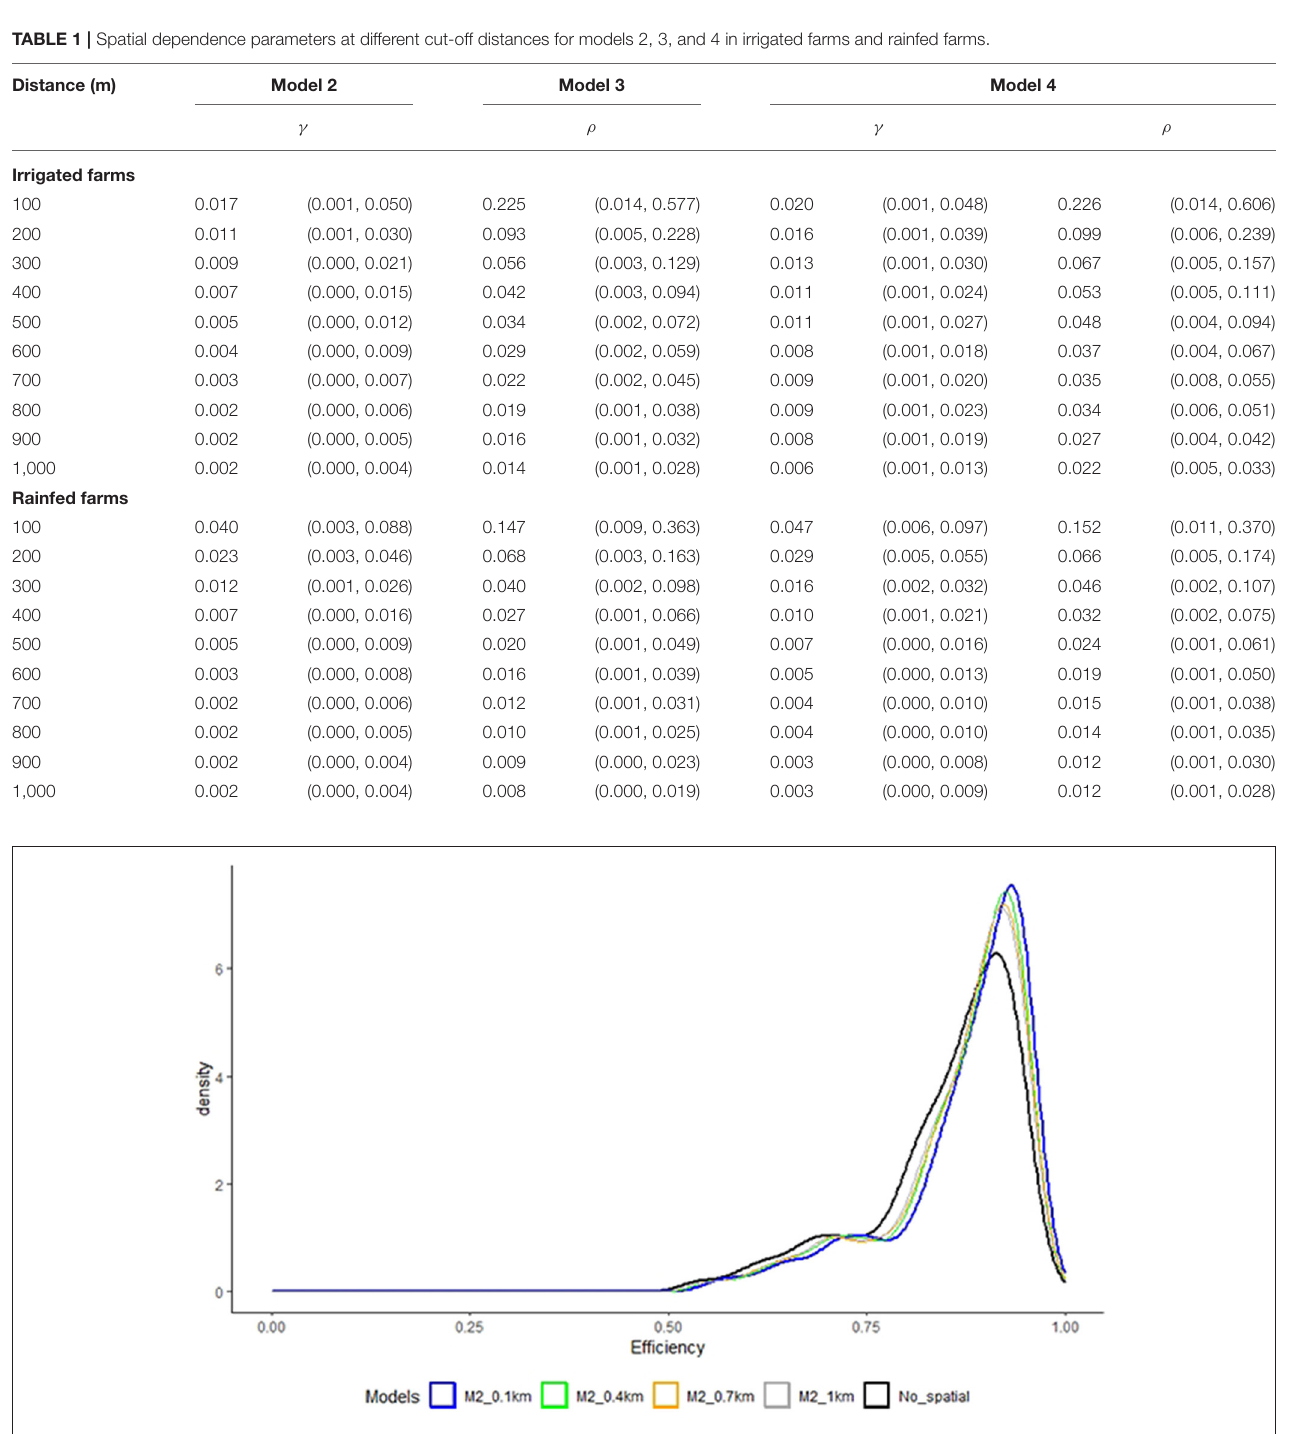
FIGURE 5 | Model 2 vs. non spatial: Farm technical efficiency distribution for rainfed farms at different cut-off